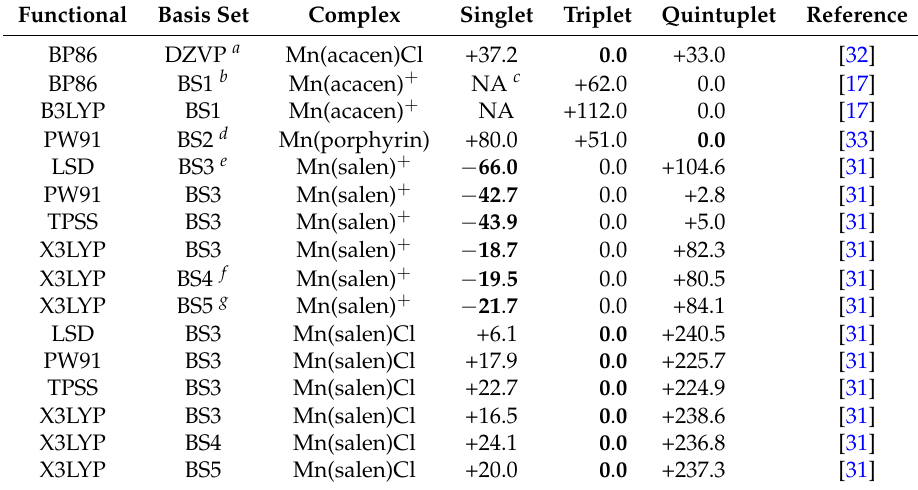
Table 2. Relative gas-phase energies (in kJ · mol –1 ) of the singlet, triplet and quintet states of Mn complexes using different DFT methods. The ground state in each entry is highlighted in bold. Functional Basis Set Complex Singlet Triplet